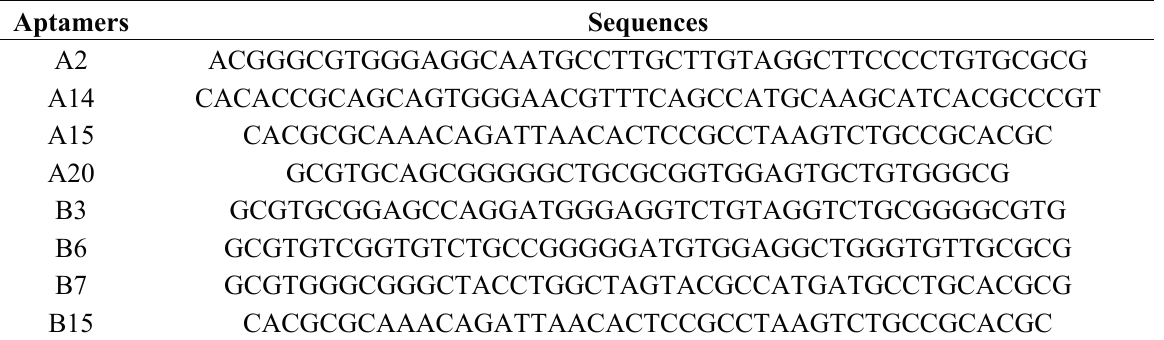
Table 1. Sequences of selected aptamers for Staphylococcus aureus